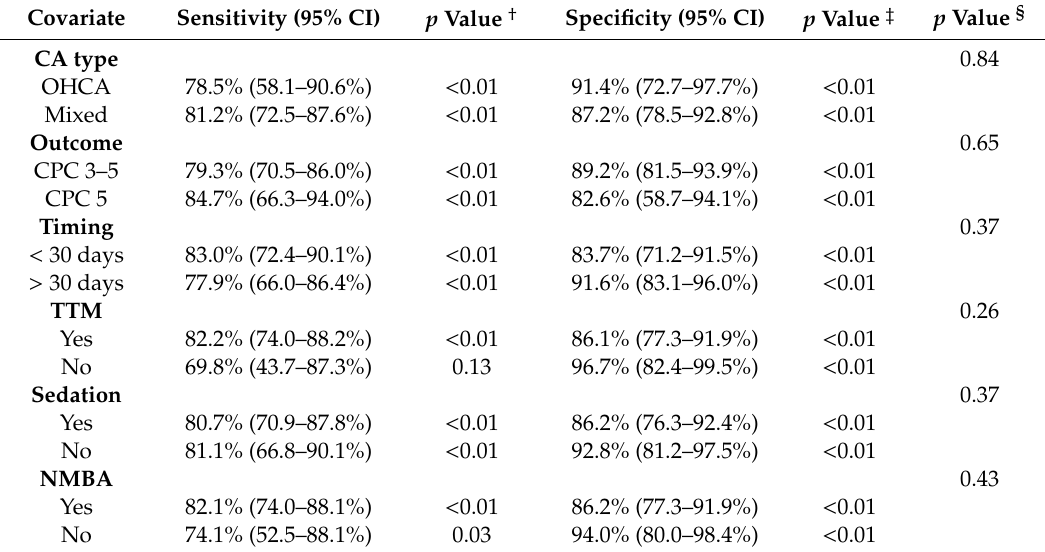
Table 2. Bivariate meta-regression models with di ff erent